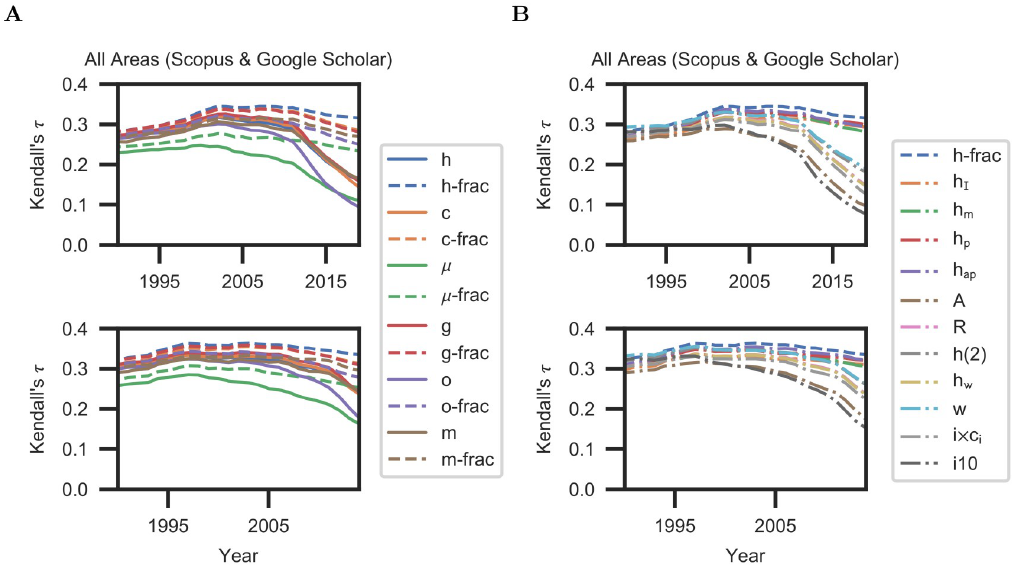
Fig 2. Effectiveness and predictive power of scientometric measures. In each subfigure, the top row depicts the correlation of bibliometric indicators and scientific awards, and the bottom row shows the predictive power five years into the future. ( A ) Evaluation across all research areas and data platforms (Scopus and Google Scholar). ( B ) Evaluation of h-frac alongside additional measures across all research areas and data